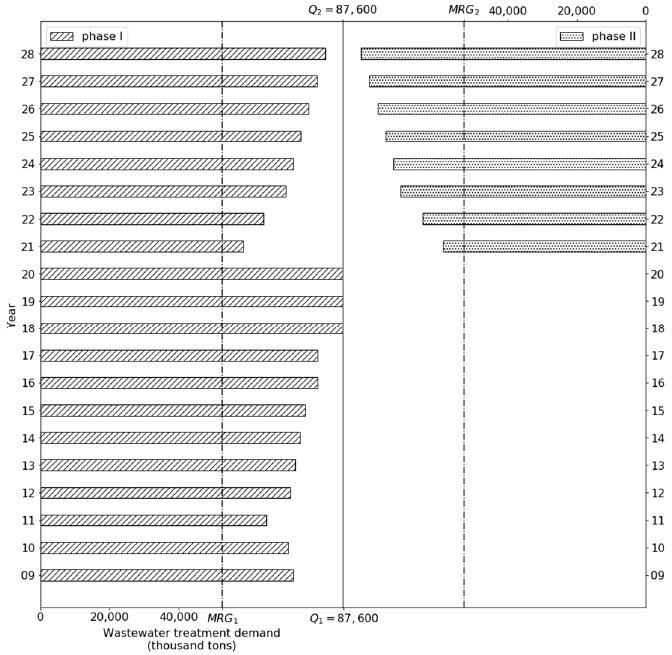
Figure 4. Demand sharing when MRG is provided to the phase II project.